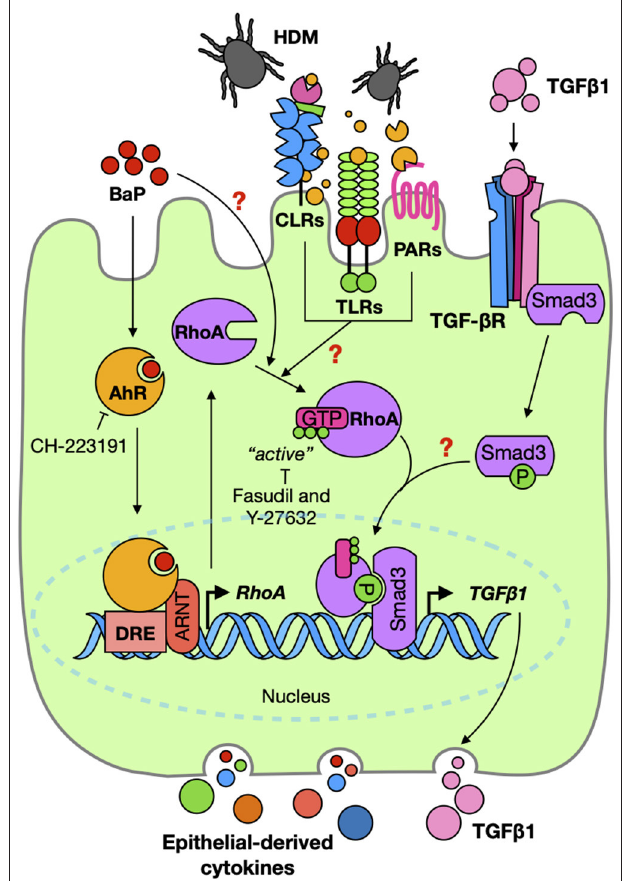
FIGURE 8 | Graphic summary. BaP co-exposure exacerbates Der f 1-induced activation of TGF β 1/Smad3 signaling through the AhR–RhoA axis in epithelial